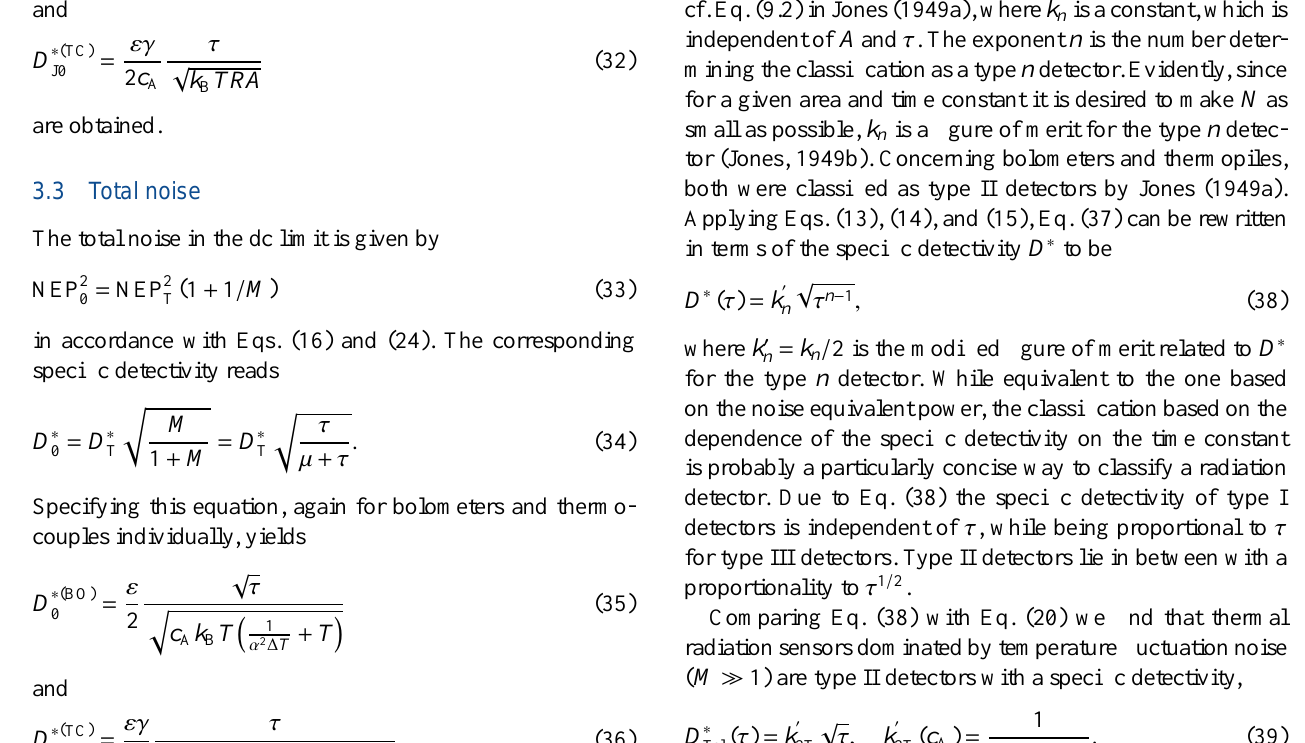
Figure 2. Options for raising the specific detectivity of thermocouples and bolometers.